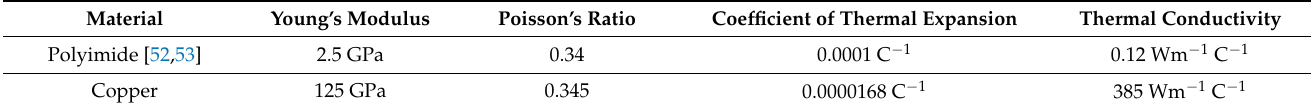
Table 5. Thermal and mechanical